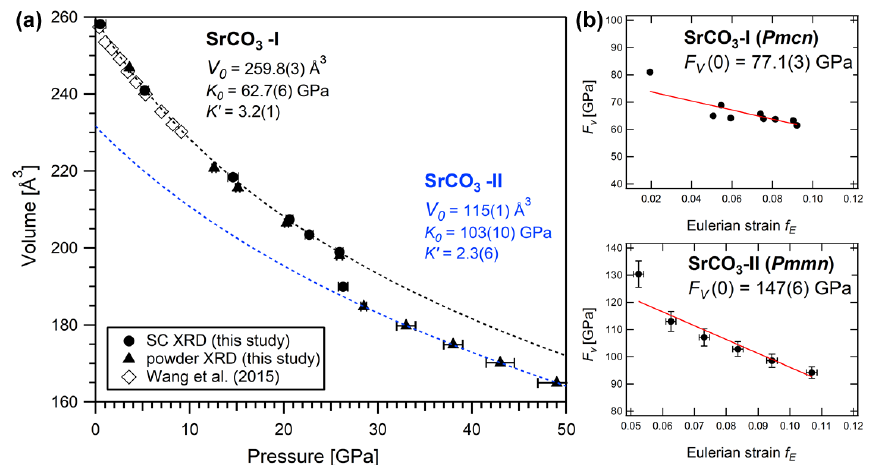
Figure 7. (a) Isothermal compression of the molar volume plotted together with the best fit following the Birch–Murnaghan equation of state for SrCO 3 -I (dashed black line) and SrCO 3 -II (dashed blue line). Open symbols are data from Wang et al. (2015) (with methanol and ethanol as PTM), and solid symbols are from this study. Note that for SrCO 3 -II the depicted data points show the doubled values of the unit cell volume. (b) Normalized pressure ( F V ) as a function of the Eulerian strain ( f ) for SrCO 3 -I and SrCO 3 -II, respectively. The solid red lines are the weighted linear fits to the data at P > 3 . 6GPa.